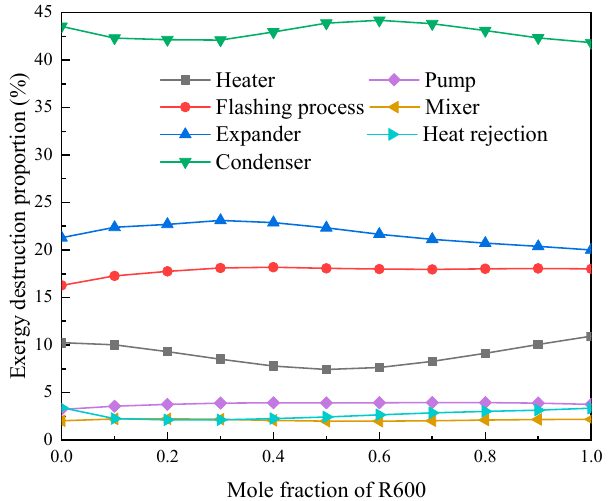
Figure 10. Variation of the exergy loss ratio of circulating components with the R600 mole fraction.